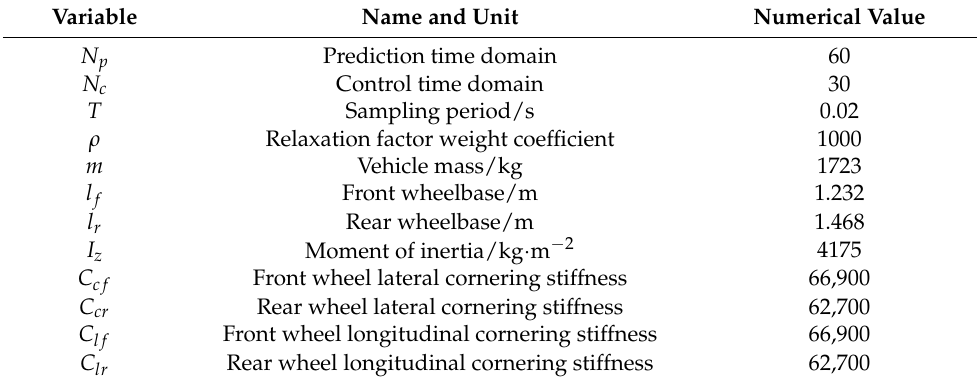
Table 1. Controller